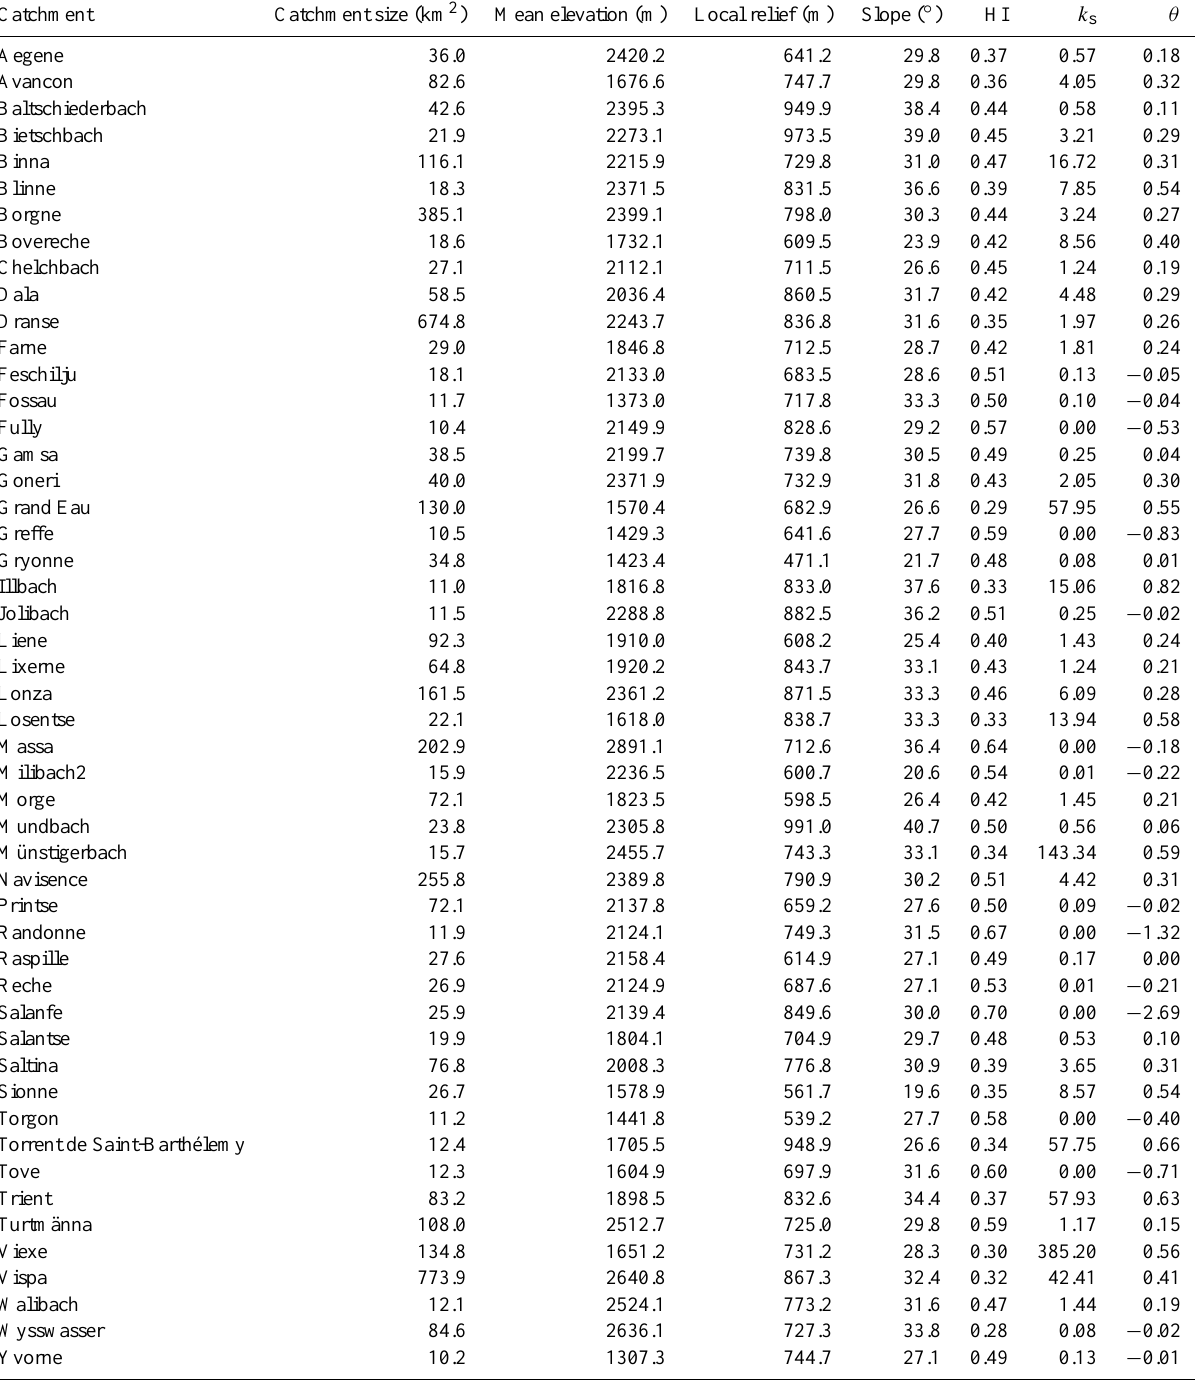
Table 1. Topographic variables (Sect. 2.1) extracted for the studied catchments.